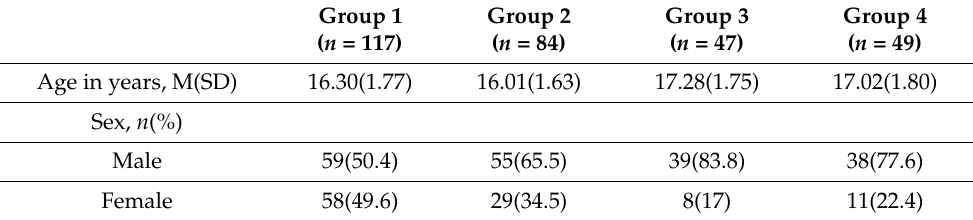
Figure 1. Recruitment process flowchart. Table 1. Sample Demographic